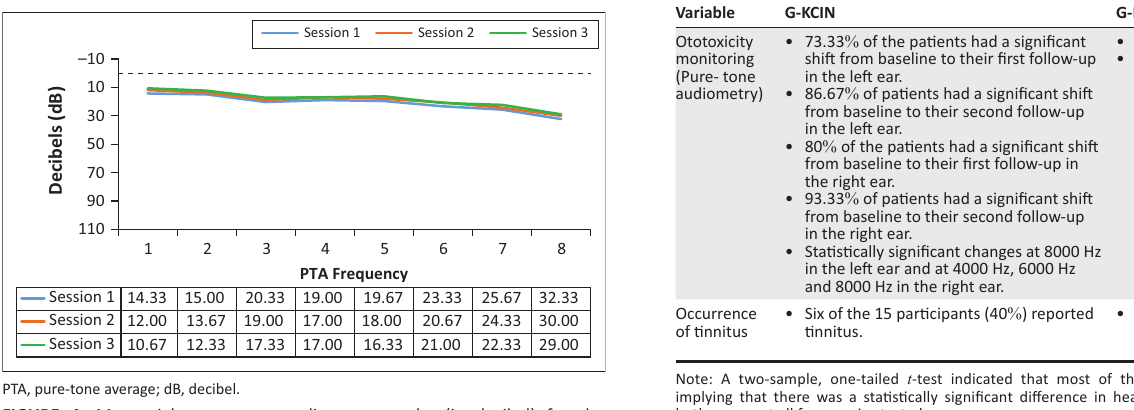
FIGURE 4: Mean right pure-tone audiometry results (in decibel) for the bedaquiline treatment, at the three different sessions ( n = 15). TABLE 2: Results of analysis of variance for pure-tone audiometry for the bedaquiline treatment, indicating level of significance for ‘within group’ analysis. Frequency